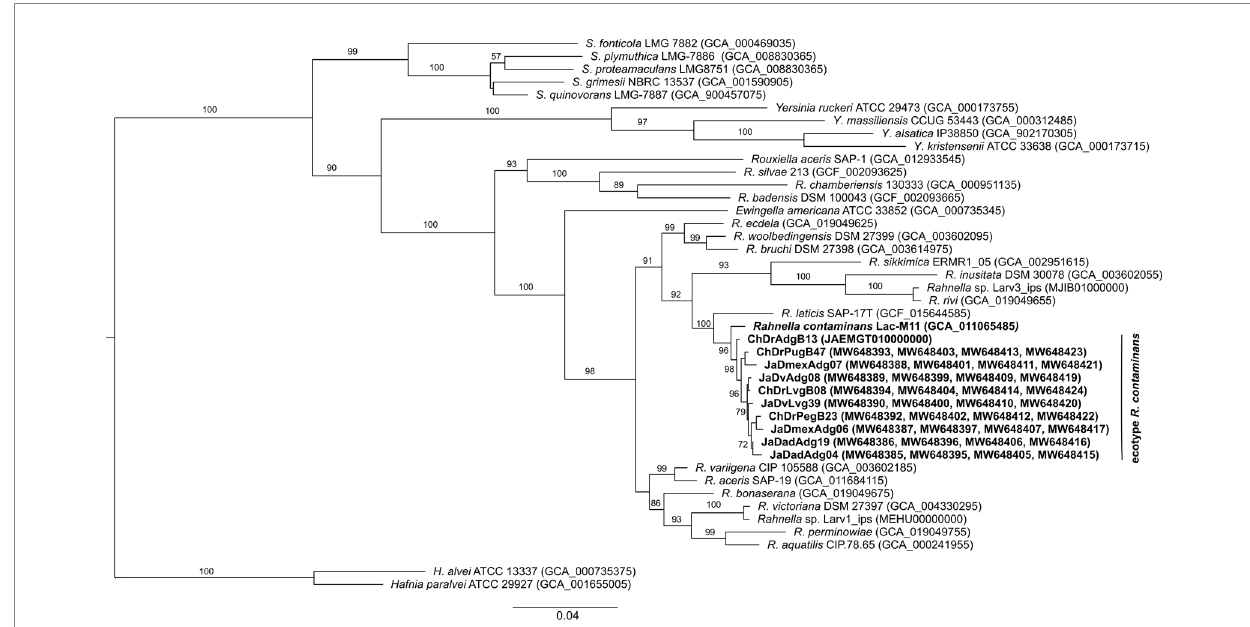
FIGURE 3 Maximum likelihood phylogenetic tree based on concatenated gyrB , rpoB , infB , and atpD gene sequences of 10 isolates and the type strains of the Rahnella species. The nucleotide substitution model was GTR + R according to Akaike criterion. Bootstrap values >50% after 1,000 pseudoreplicates are shown at